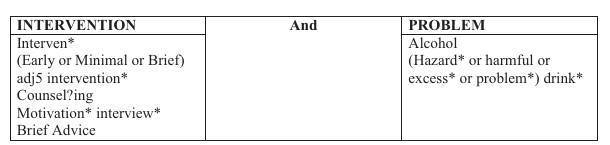
FIGURE 1 | Search strategy utilized in the review